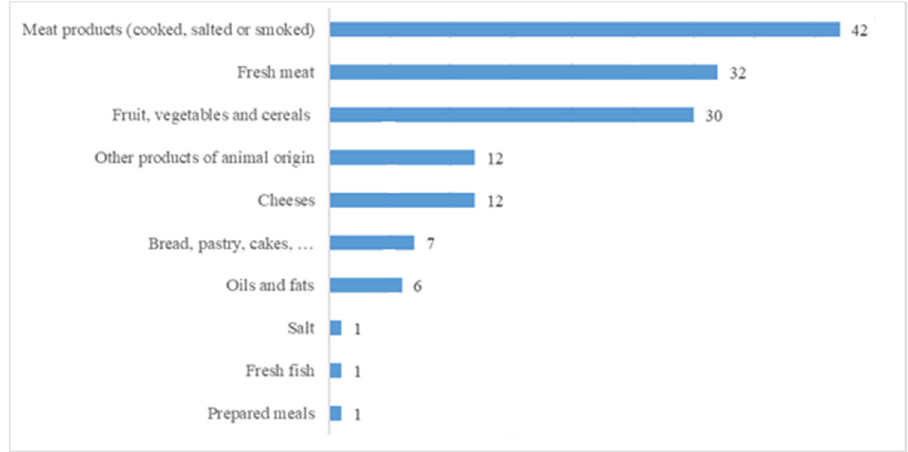
Figure 4: Distribution of traditional products by categories. Source: Own computation based on data gathered from eAmbrosia ( July 2022 )